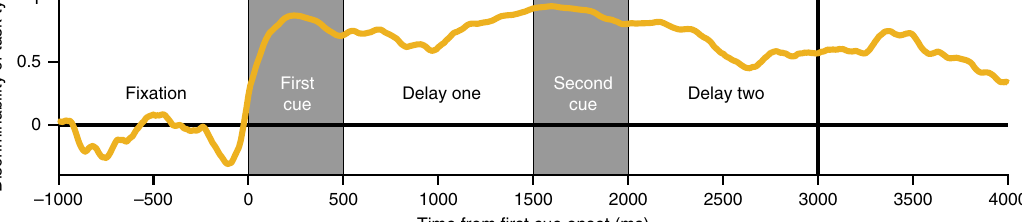
during delay-two, as at this point the subject has been exposed to the same visual stimuli, just in reverse